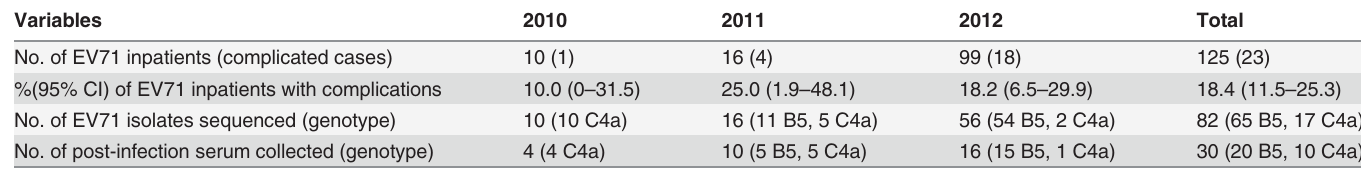
Table 1. Number of EV71 inpatients and virus genotypes identi fi ed in a medical center in Northern Taiwan, 2010 – 2012.